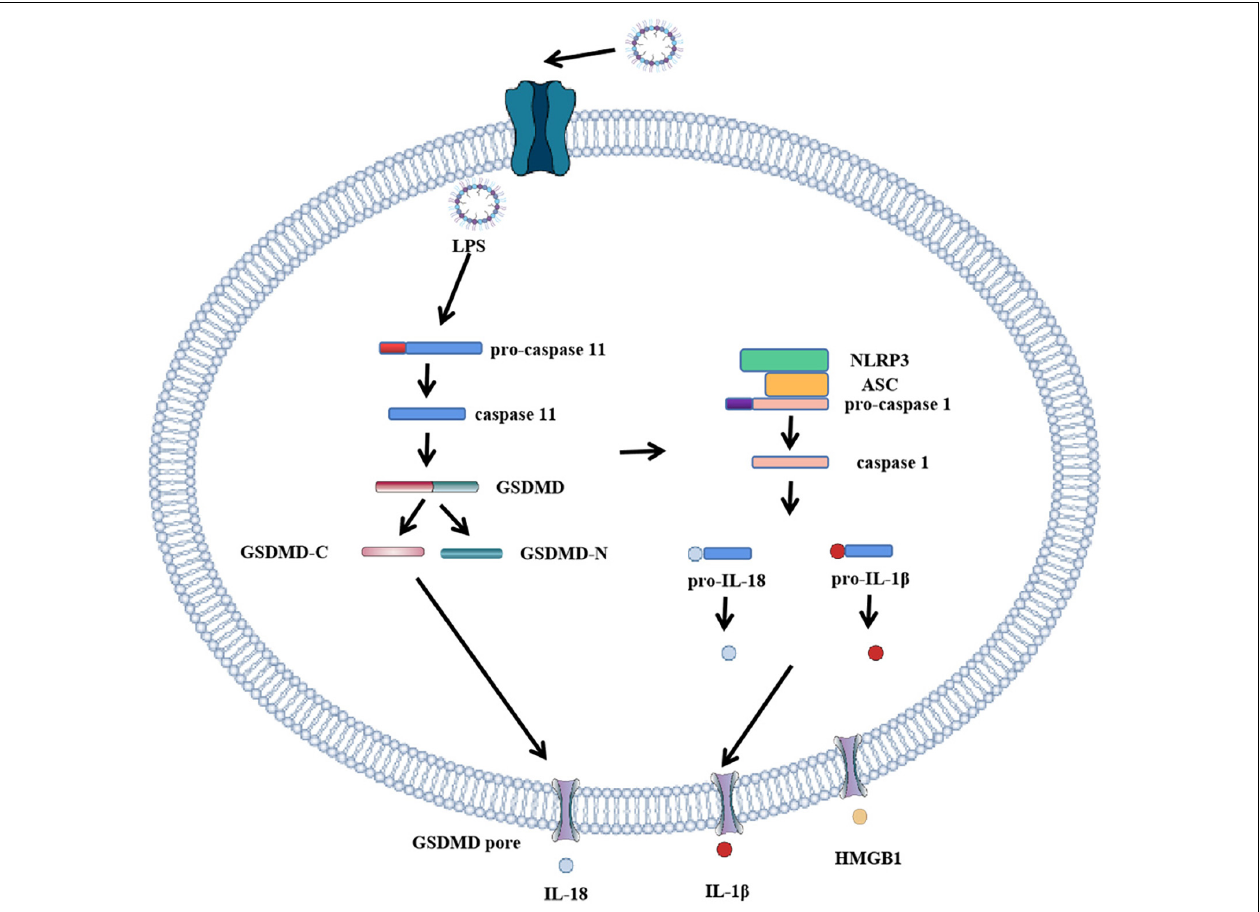
FIGURE 2 | Role of GSDMD in non-canonical inflammasome activation. The canonical pathway of pyroptosis. When LPS enters cells, it directly participates in and activates human caspase-4 and caspase-5 and mouse caspase-11. Caspase-11 cleaves GSDMD, forming GSDMD-C and GSDMD-N. GSDMD-N cluster and bind to the plasma membrane. Formation of GSDMD pore, the formation of GSDMD pore activates inflammasome to bind to caspase-1, activated caspase-1 activates IL-18 and IL-1 β , and cytokines IL-18 and IL-1 β are released extracellularly through GSDMD